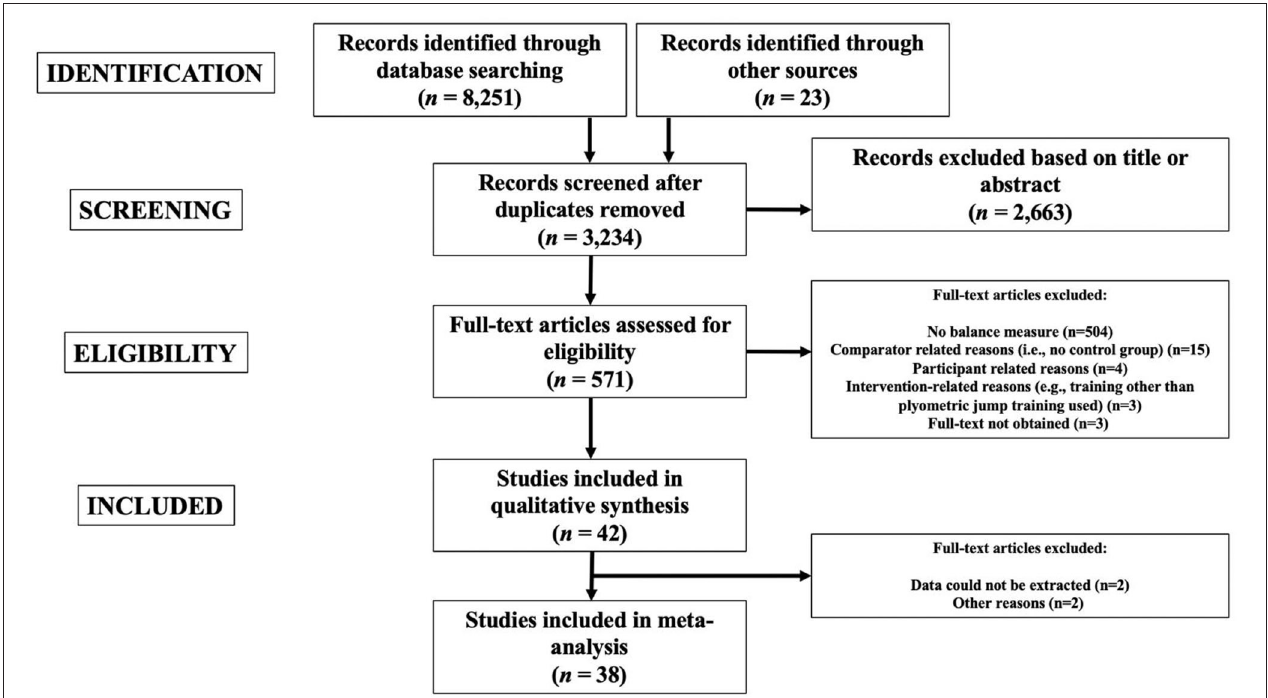
FIGURE 1 | The PRISMA flow